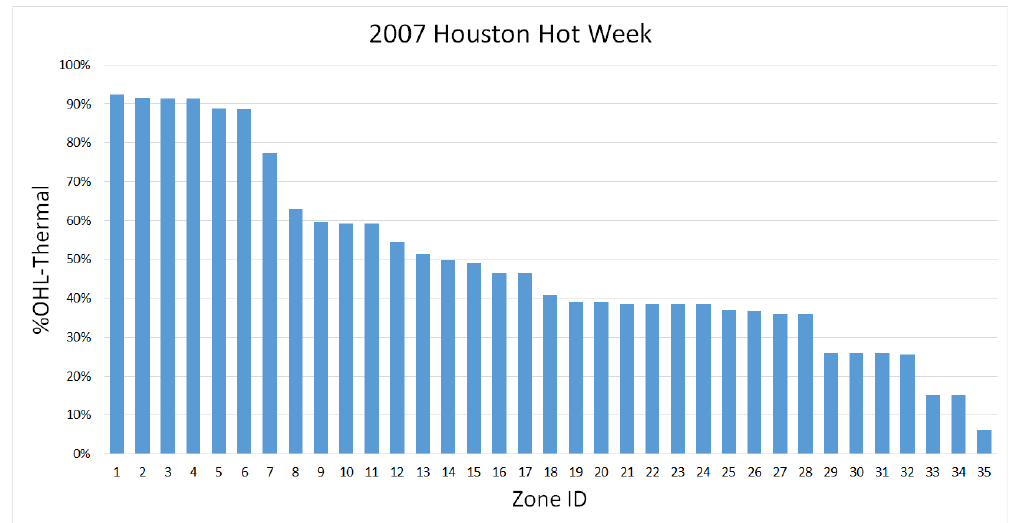
Figure 6. Thermal OHL in different zones for a hot weather week in Houston.